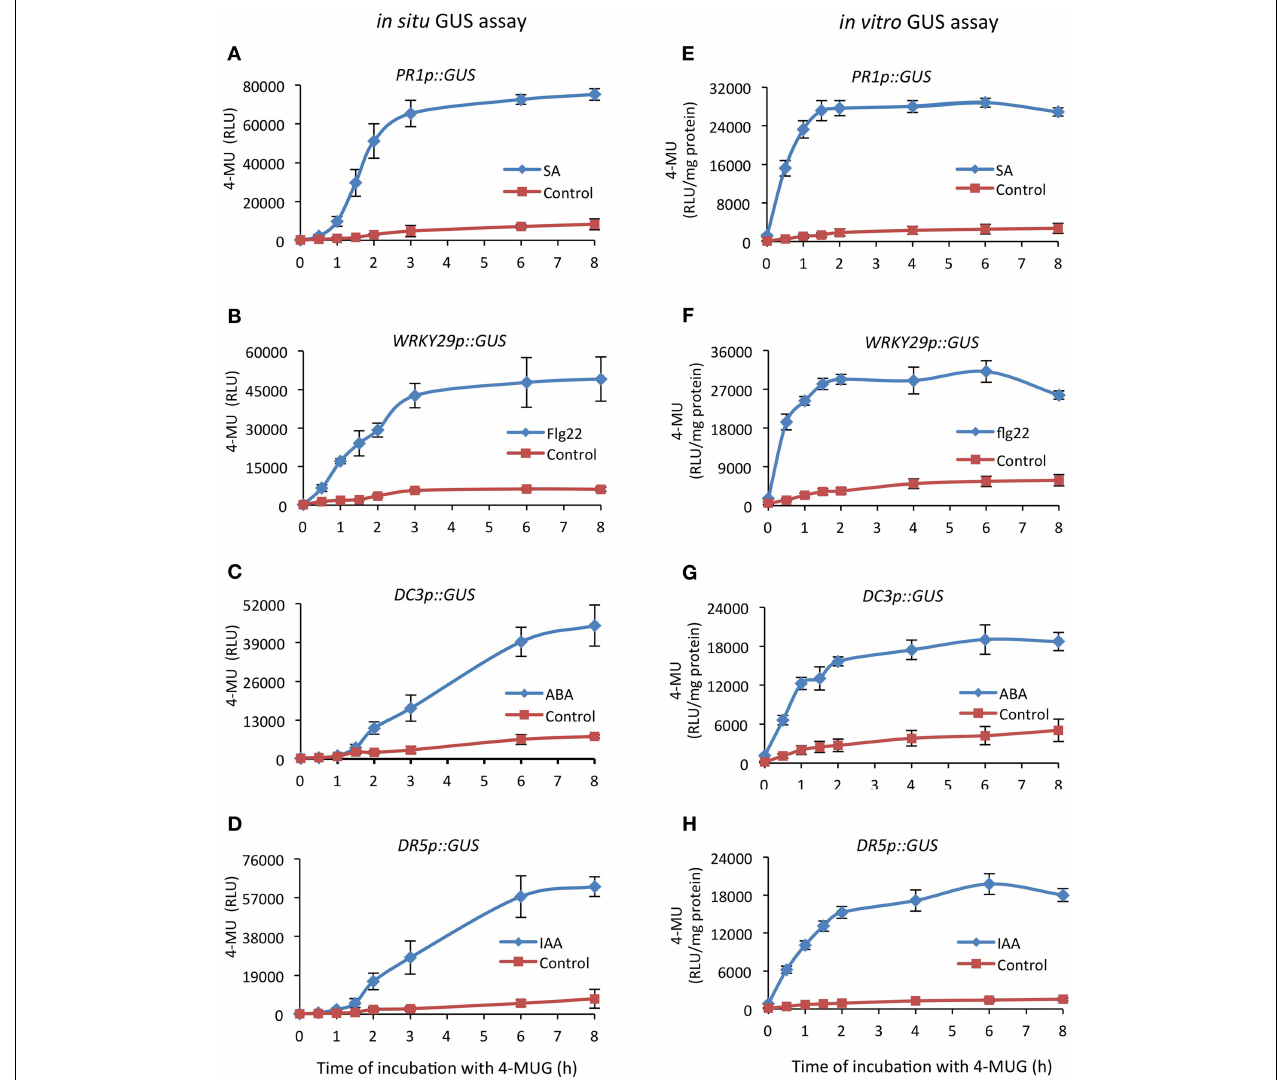
FIGURE 2 | Comparison of GUS activity determined in whole seedlings ( in situ ) and in protein extracts ( in vitro ). Seedlings of transgenic Arabidopsis thaliana lines harboring different inducible promoter–GUS fusions were grown for 12 days hydroponically in microplates and then treated with the respective inducer (or solvent as control) for an appropriate time period to obtain high expression levels of the reporters. (A,E) PR1p::GUS seedlings received 200 μ M SA for 24h, (B,F) WRKY29p::GUS received 1 μ M flg22 for 4h, (C,G) DC3p::GUS received 100 μ M ABA for 24h and (D,H) DR5p::GUS received 5 μ M IAA for 4h. Following this treatment, the medium was removed and for monitoring GUS activity in situ (A–D) , seedlings were